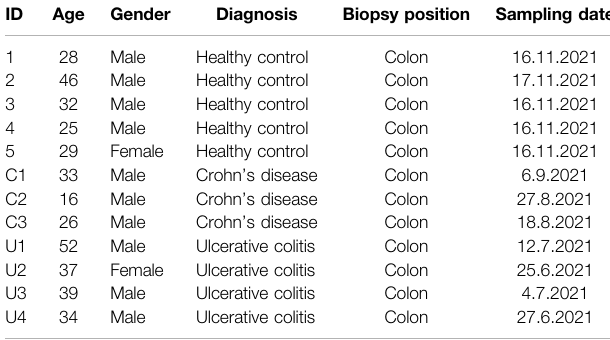
TABLE 1 | Volunteers recruited in the experimental